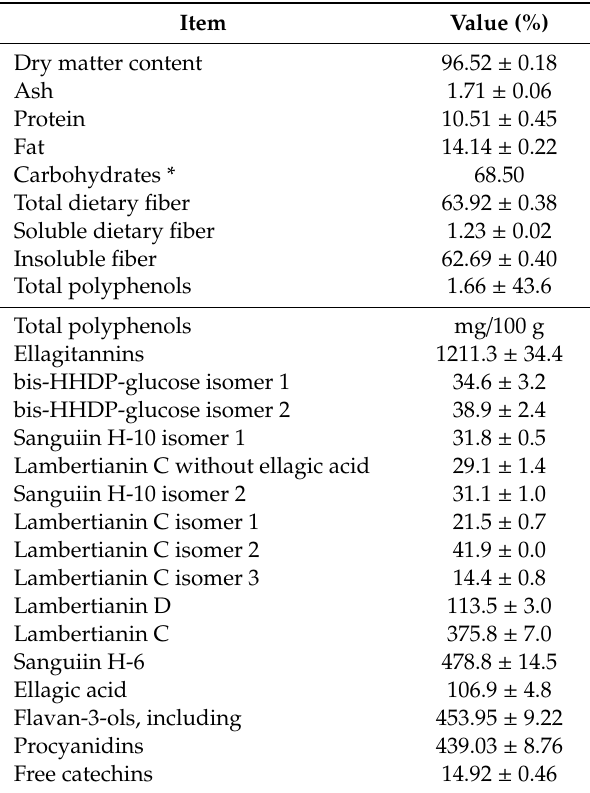
Table 1. The characterization of ground raspberry